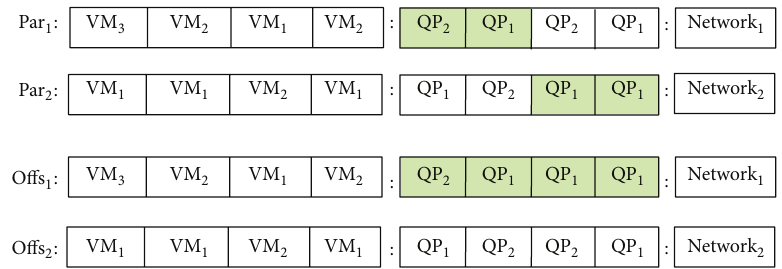
Figure 7: Local crossover operator for the multiobjective optimization of query workloads.